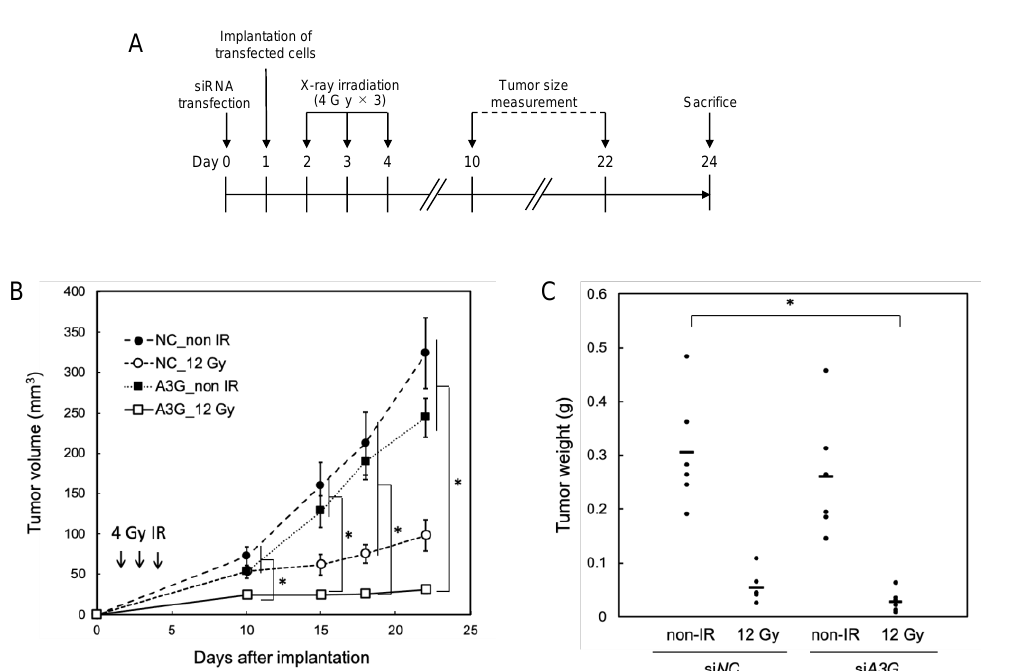
Figure 4. Radiosensitization effect of A3G knockdown on xenograft model of A549 cells. ( A ) Scheme of experiment. A549 cells were transfected with either the control (si NC ) or si A3G -1 and were subcutaneously implanted with Matrigel in the left hind legs of nude mice and then local irradiation with X-ray at 4 Gy was carried out on days 1 to 3 after implantation. ( B ) Tumor volumes of non- irradiated mice and irradiated mice of control and si A3G -1 transfected groups. n = 6. * p <0.05. ( C ) Tumor weights measured for each mouse in the groups. * p <0.05.